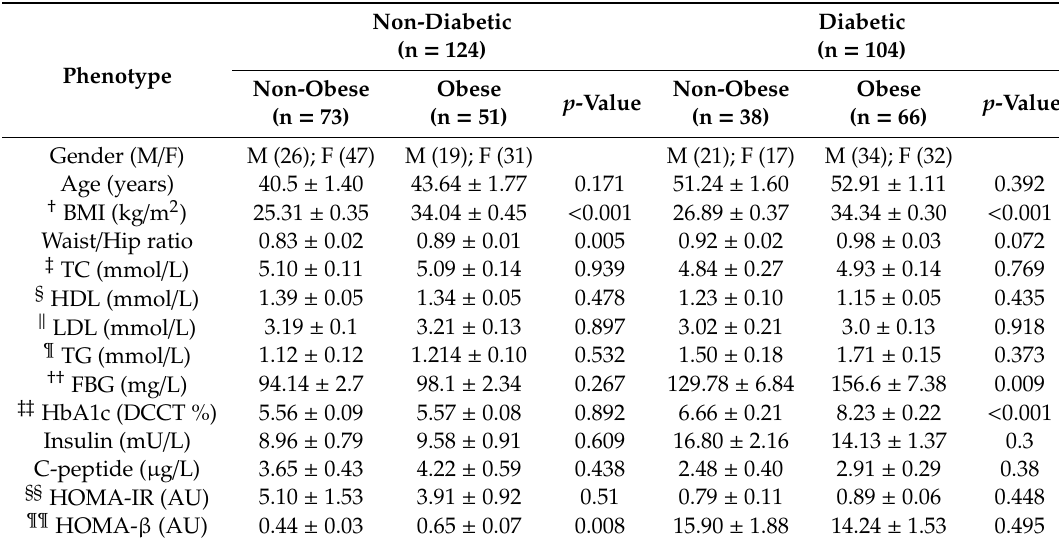
Table 3. Physical and biochemical characteristics of the non-diabetic and diabetic population categorized based on